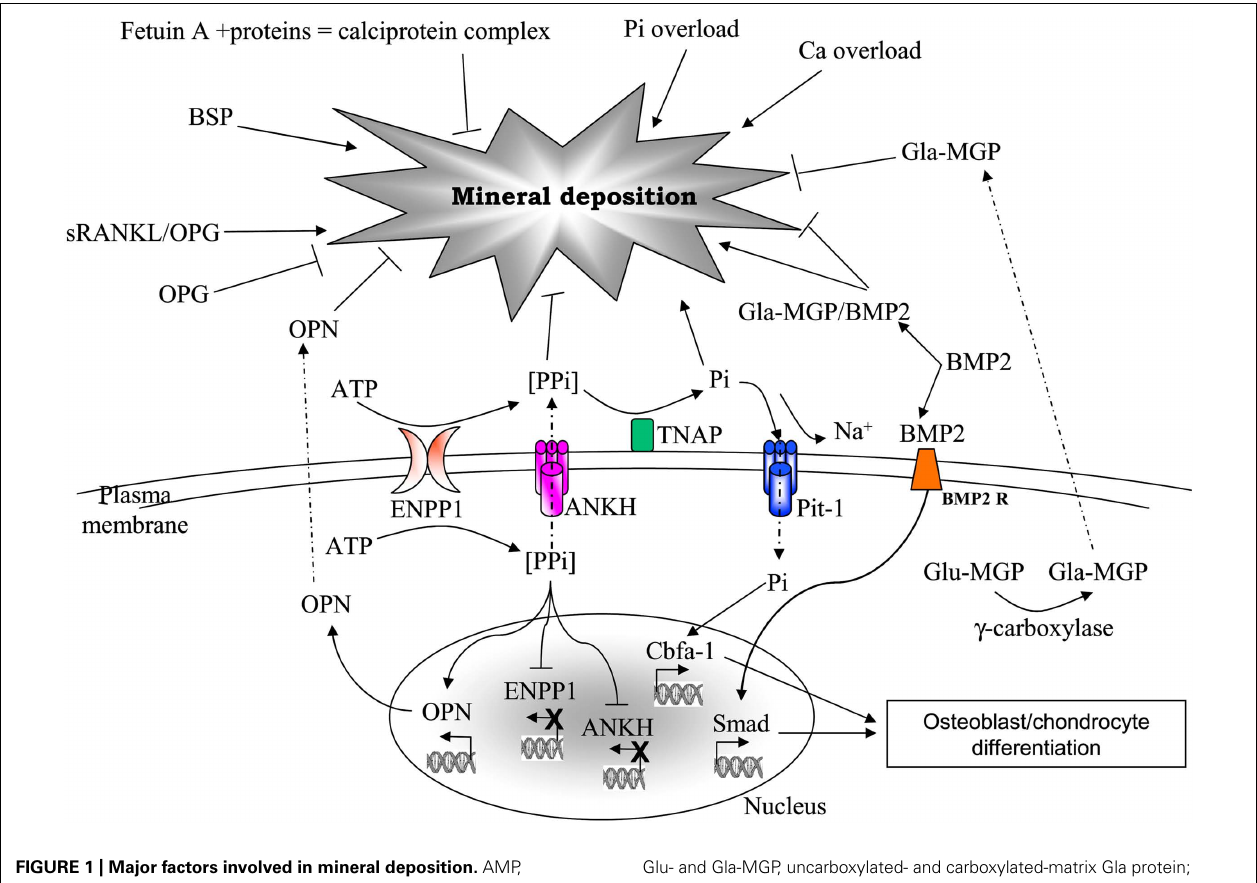
FIGURE 1 | Major factors involved in mineral deposition. AMP, adesosine monophosphate; ANKH, ankylosis protein homolog; ATP, adenosine triphosphate; BMP2, bone morphogenetic protein-2; BMP2R, bone morphogenetic protein-2 receptor; BSP, bone sialoprotein; Ca, calcium; ENPP1, ectonucleotide pyrophosphatase/phosphodiesterase;